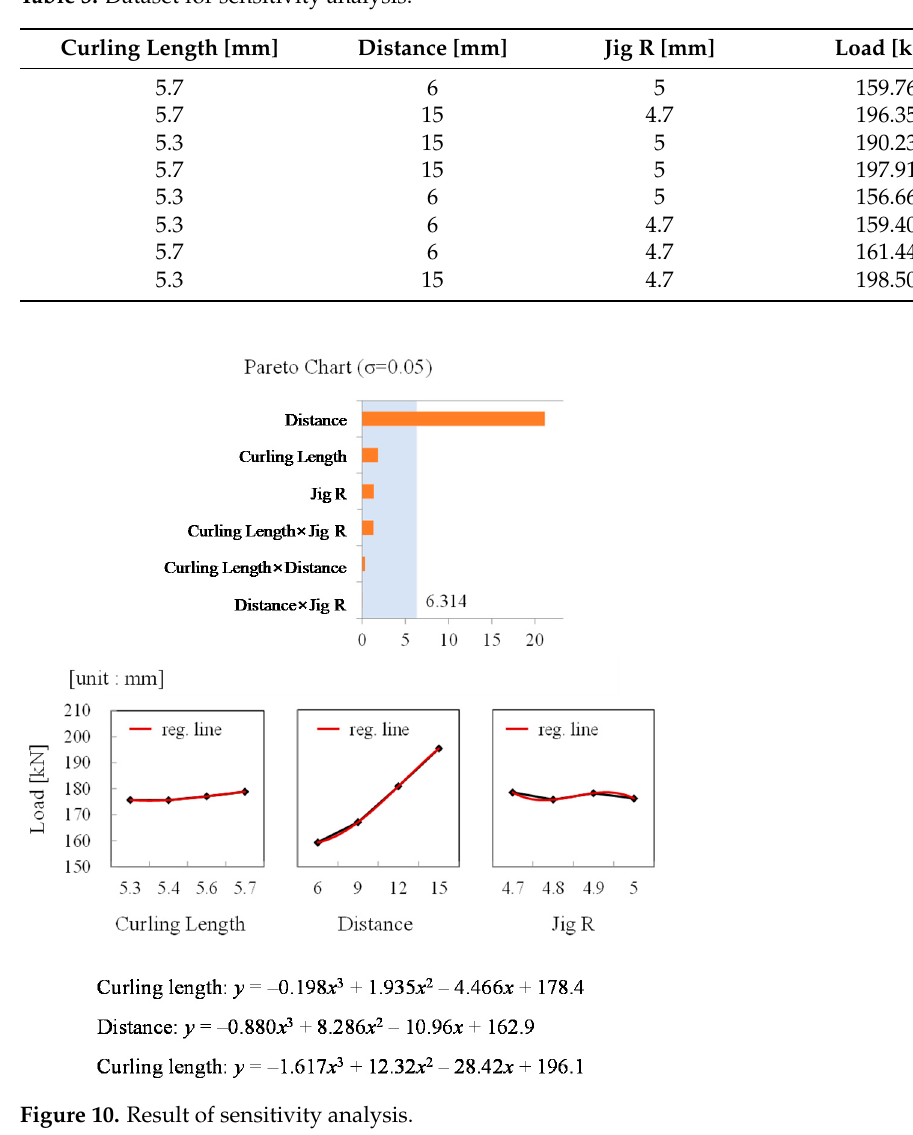
Figure 10. Result of sensitivity analysis.